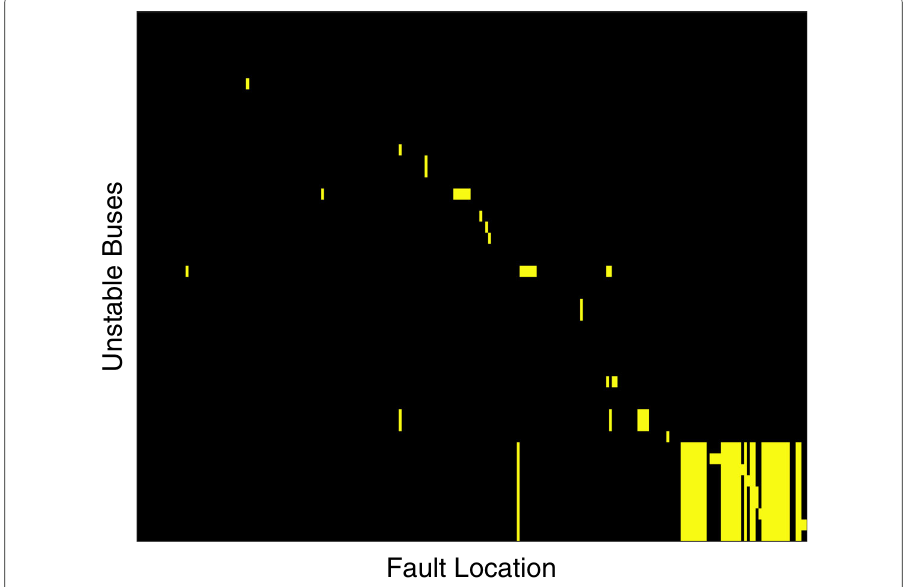
Fig. 4 Unstable Buses Based on Fault Location. A systematic exploration of the network locations of unstable dynamics as a function of the line where the initial fault was applied. Each column represents a different simulation with a different fault location, with yellow pixels denoting which buses exhibited instability during that